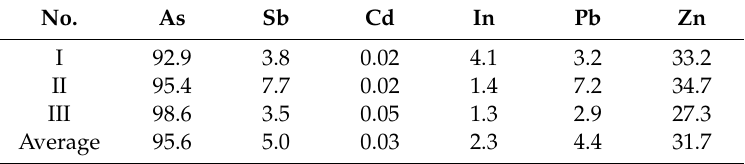
Table 3. Leaching e ffi ciencies of confirmation experiments under the optimized conditions (%).